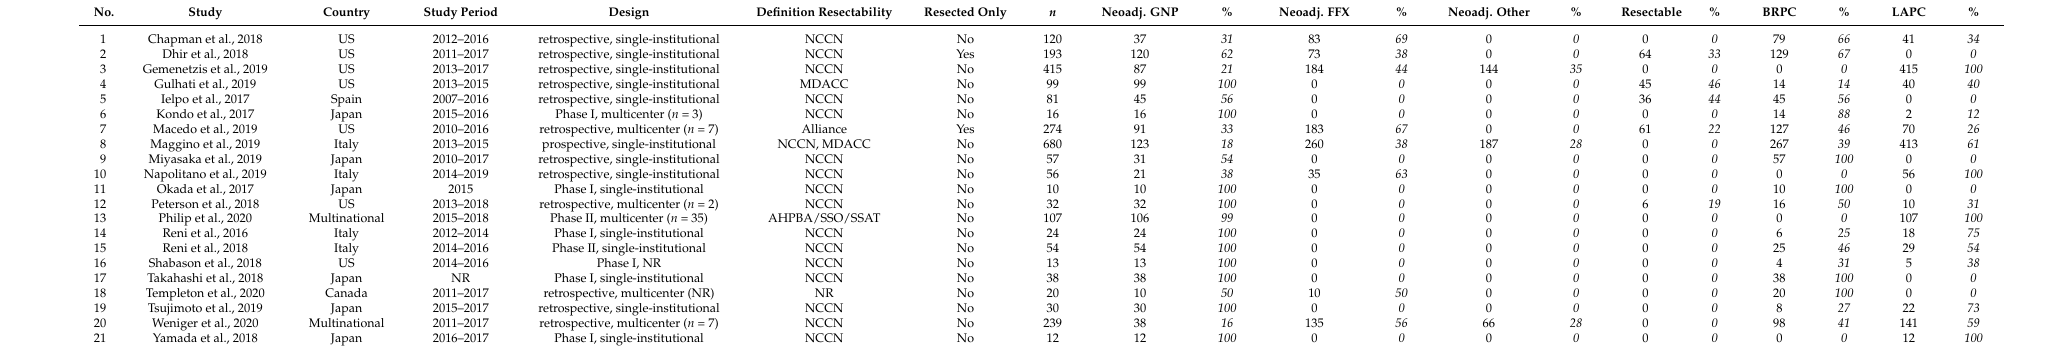
Table 1. Study characteristics including proportions of neoadjuvant treatment and resectability status